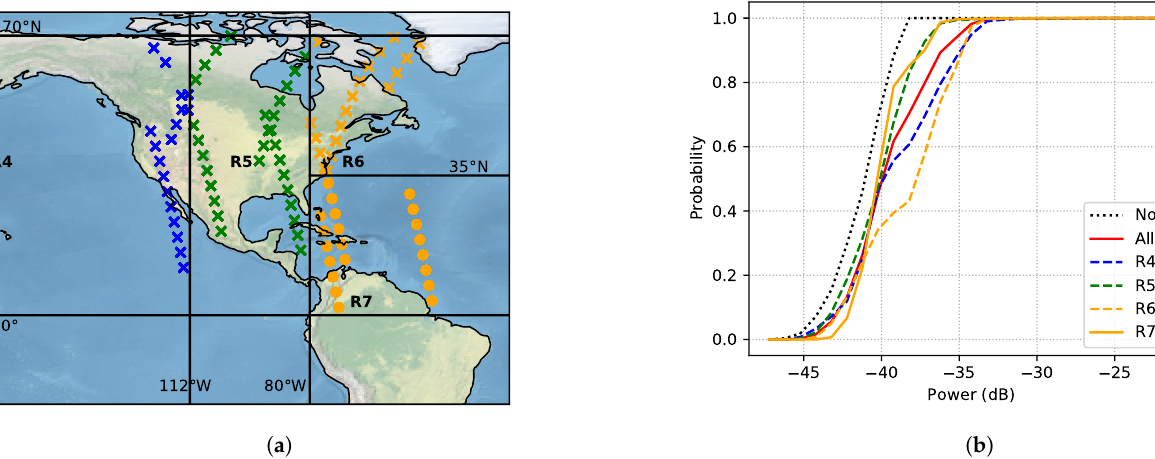
Figure 10. Power distribution over America divided in four regions. The colour blue is for western, green for central, and orange for eastern areas. ( a ) Measurement locations over several orbits. The regions R 4, R 6 and R 7 cover 40 ◦ of longitude; and the middle region R 5 covers 30 ◦ . R 4 and R 5 cover 70 ◦ of latitude; and R 6 and R 7, 35 ◦ . ( b ) ECDF of received power over the four regions, including the noise floor measurements (black dotted line). The yellow continuous line is linked to the circles in the map and dashed lines to crosses. The red line is the ECDF of all the points in the